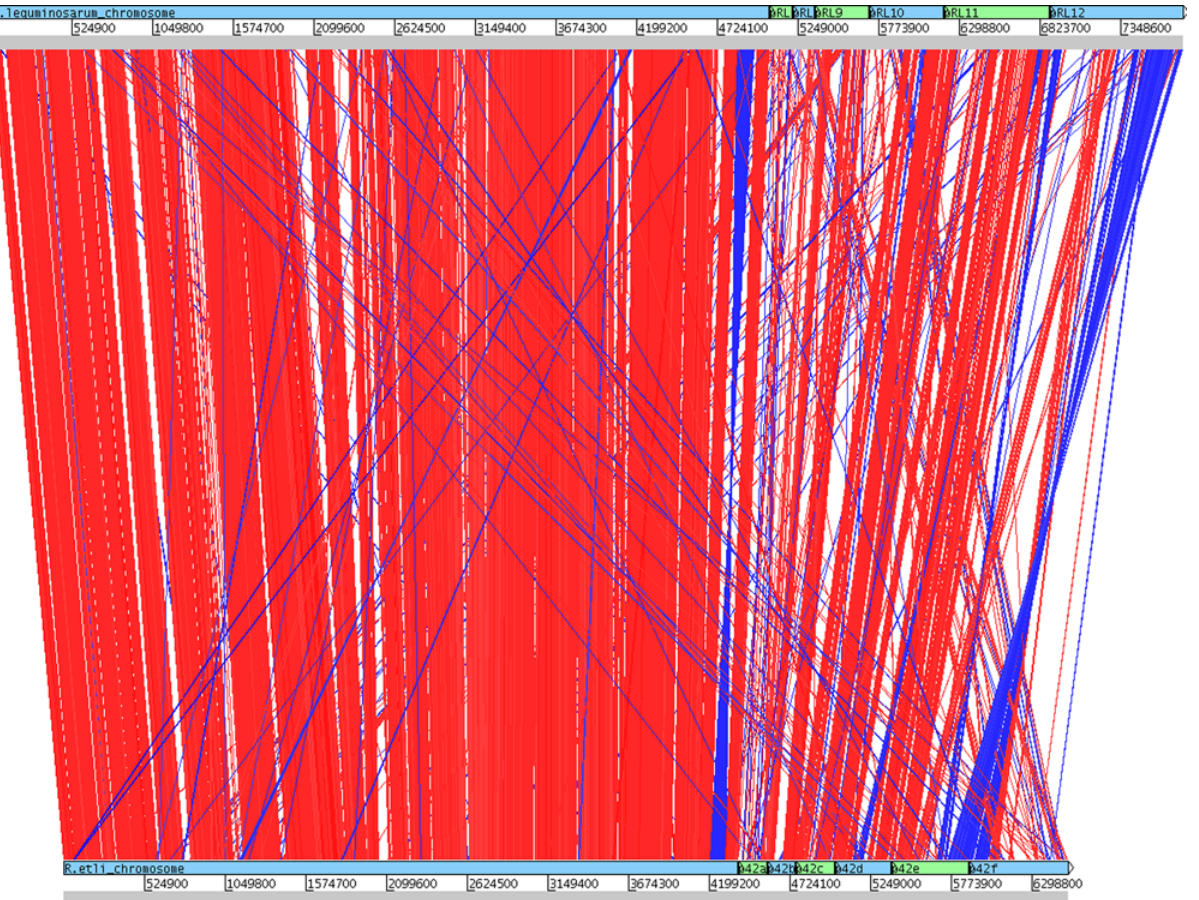
Figure 2. ACT View of Chromosome and Plasmids. The chromosomal and plasmid DNAs have been laid end-to-end and analysed using the Artemis comparison tool (ACT) [15]. Red bars represent close matches, whilst blue bars represent inverted close matches. The R. leguminosarum genome is at the top of the figure with replicons in the order Chromosome, pRL7, pRL8, pRL9, pRL10, pRL11, pRL12 whilst the R. etli genome is shown at the bottom of the figure in order Chromosome, p42a, p42b, p42c, p42d, p42e,